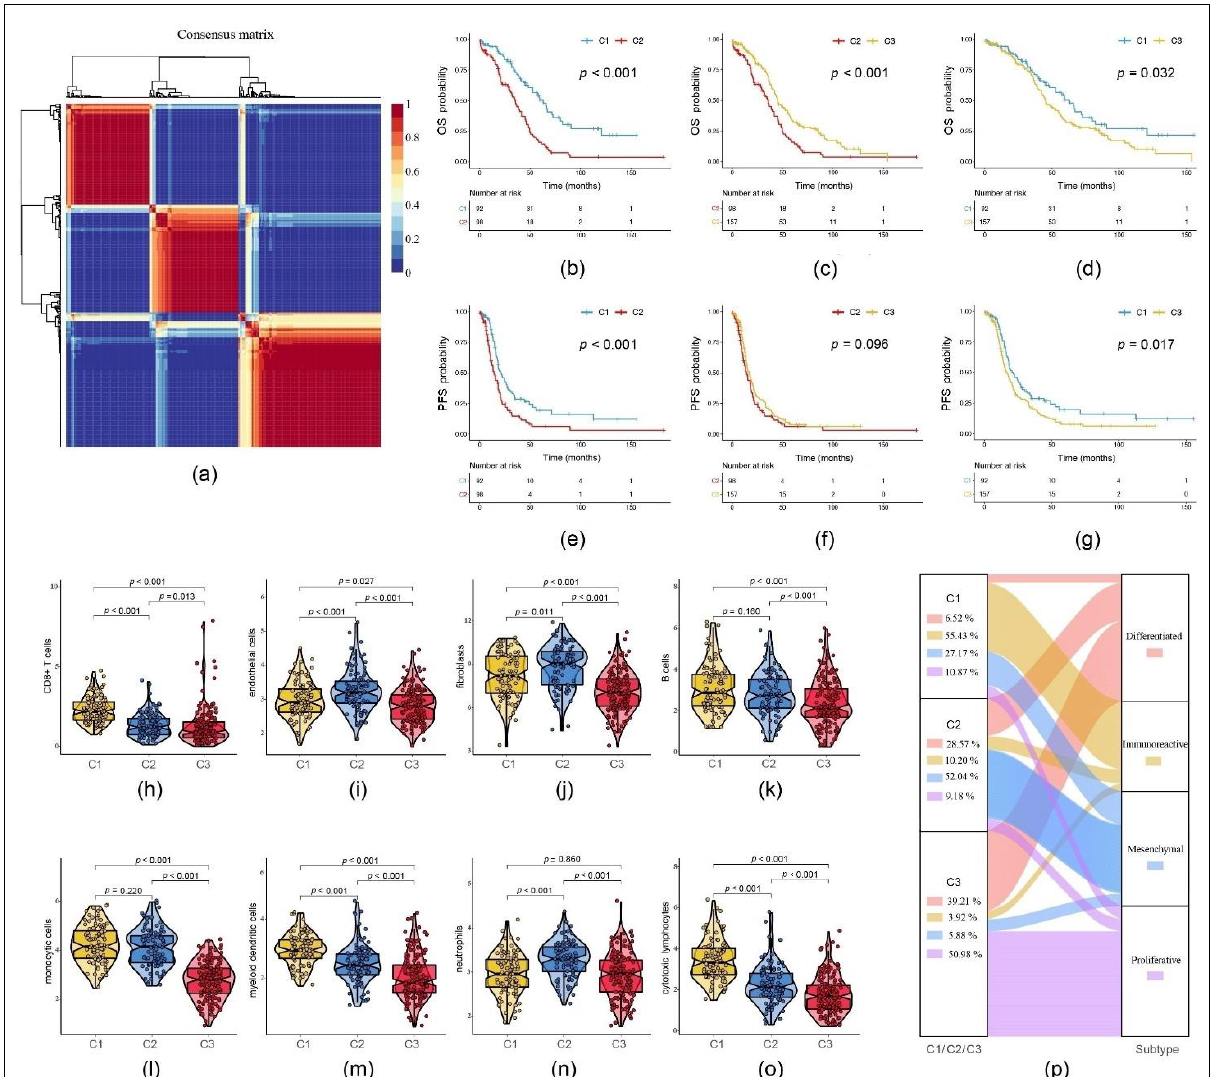
Figure 1. Comparison of the three clusters 1, 2 and 3 (C1, C2 and C3): ( a ) Consensus map clustered via the non-negative matrix factorization (NMF) algorithm. ( b – g ) Overall survival (OS) and progression-free survival (PFS) showed significant differences. ( h – o ) Immune scores of cells of the tumor microenvironment (TME) showed significant differences. ( p ) Percentage of the four molecular subtypes accounting for each of the three clusters.